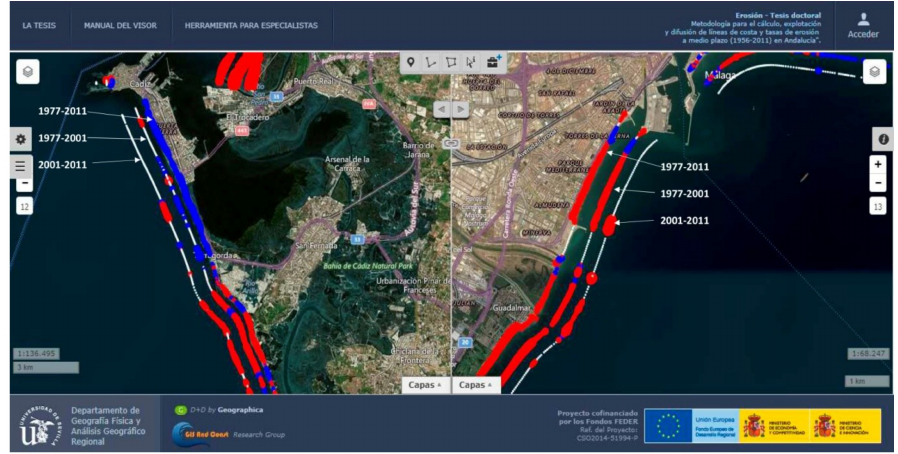
Figure 9. Visualization of the erosion rates over a orthophoto for different time periods in C á diz (on the left) and M á laga (on the